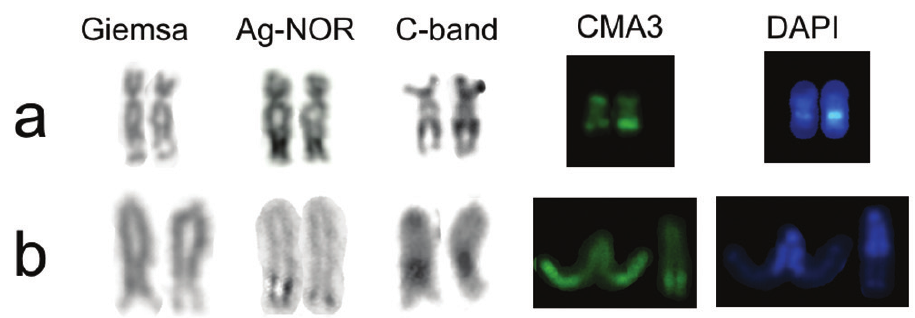
Figure 6. NOR-bearing chromosomes of Pterygoplichthys anisitsi (upper row – a ) and Farlowella amazonum (lower row – b